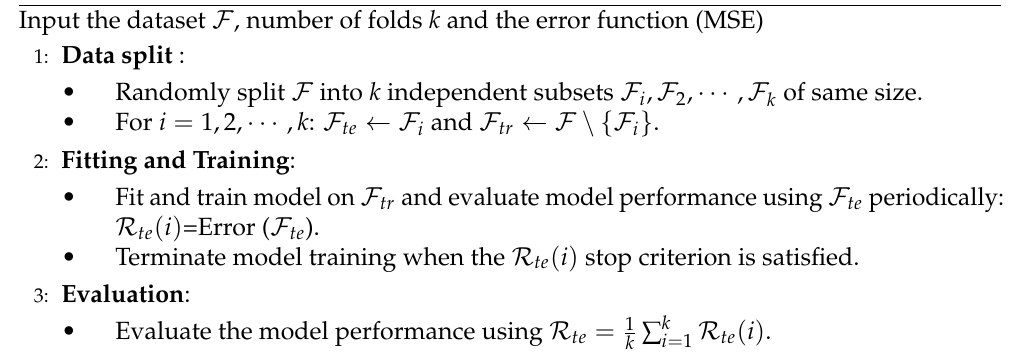
Algorithm 1 Pseudocode for the k -fold cross validation